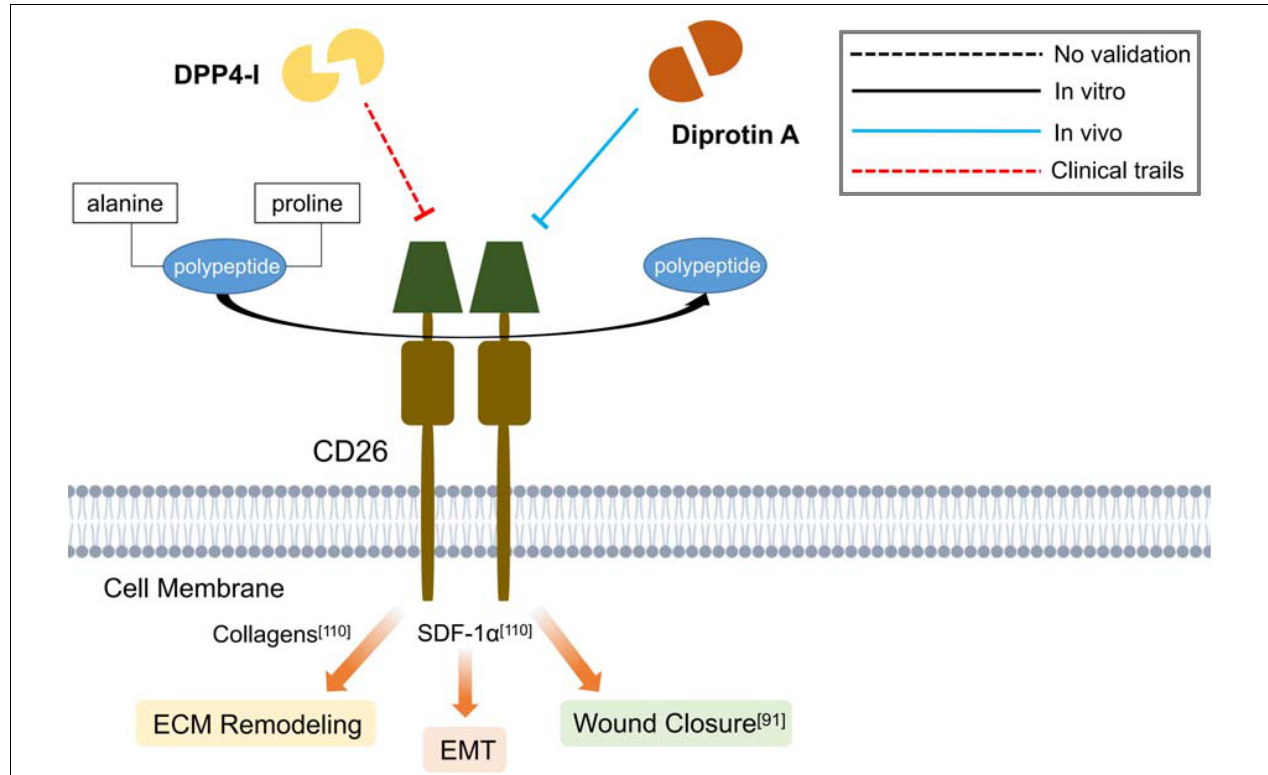
FIGURE 4 | Schematic graph showing potential antifibrotic therapies targeting CD26. (DPP4-I, dipeptidyl peptidase-4 inhibitor; SDF-1 α , stromal cell-derived factor 1 α ; EMT, epithelial-mesenchymal transition; ECM, extracellular matrix).